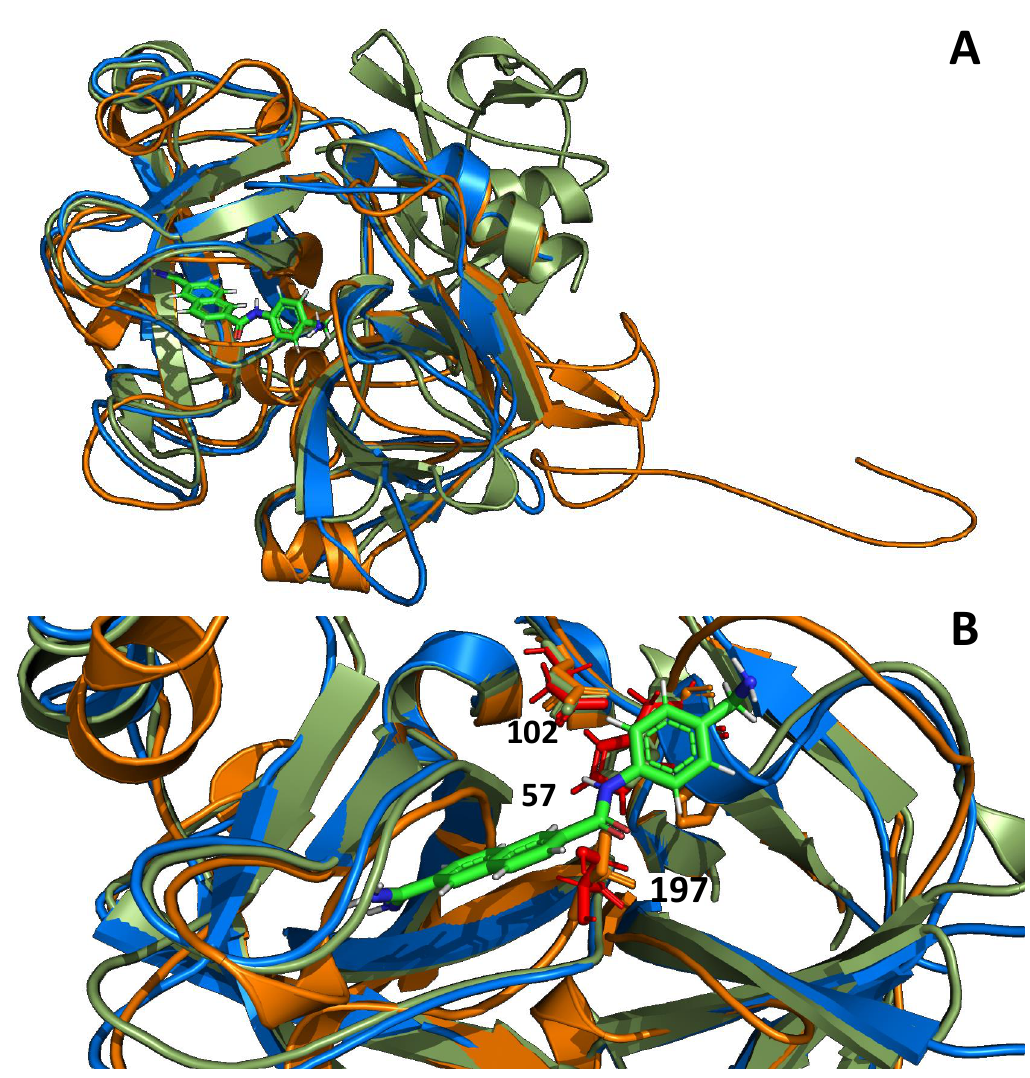
Figure 1. A: TMPRSS2 homology models based on 5ce1 (serine protease hepsin) in brown, 1gpz (zymogen catalytic domain of complement protease C1R) in green, aligned with urokinase 4fuc in blue. Transmembrane domain of two models differ significantly in part to be shorter in 5ce1 and 1gpz tan in TMPRSS2. B: enlarged models of TMPRSS2 aligned with uPA. Catalytic triad (57, 102, 197) has very similar spatial positioning with exception of histidine 57 (numbered 296 in the model) of TMPRSS2 modeled after 5ce1. Urokinase inhibitor (6-[(Z)- Amino(imino)methyl]-N-[4-(aminomethyl)phenyl]-4-(pyrimidin-2-ylamino)-2-naphthamide) positioned in the specificity pocket is colored by atoms (carbon in green, nitrogen in blue, oxygen in red, hydrogen in gray), uPA amino acids 57, 102, 195 are shown in red.